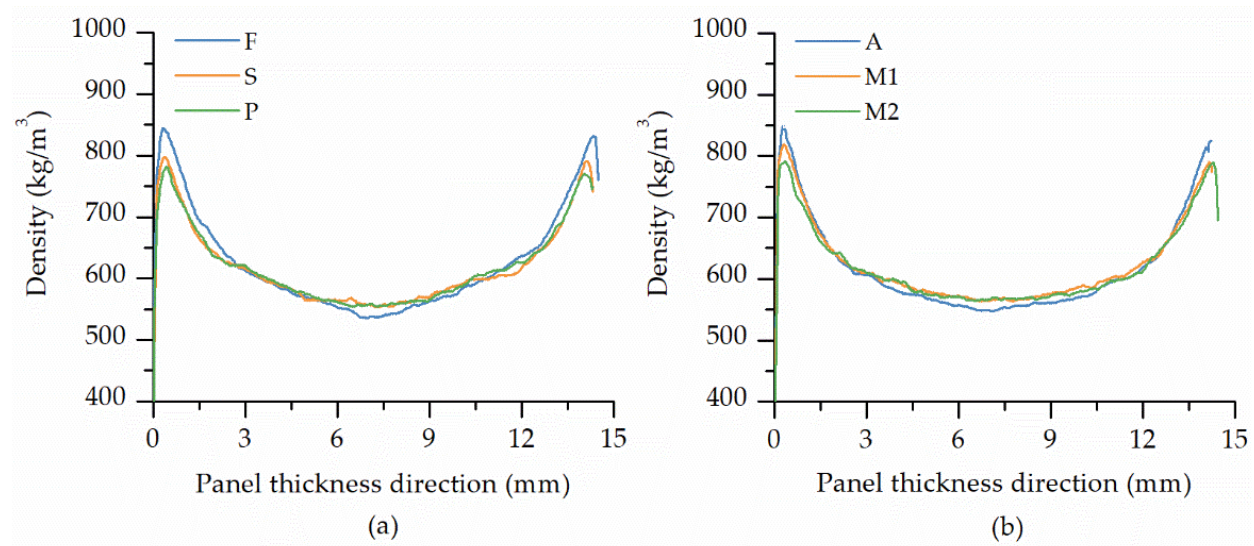
Figure 2. Average vertical density profiles of ( a ) balsam fir panels (F), black spruce panels (S), and jack pine panels (P), and ( b ) aspen panels (A), M1 panels (33.3% spruce/66.6% aspen mixture), and M2 panels (66.6% spruce/33.3% aspen mixture).